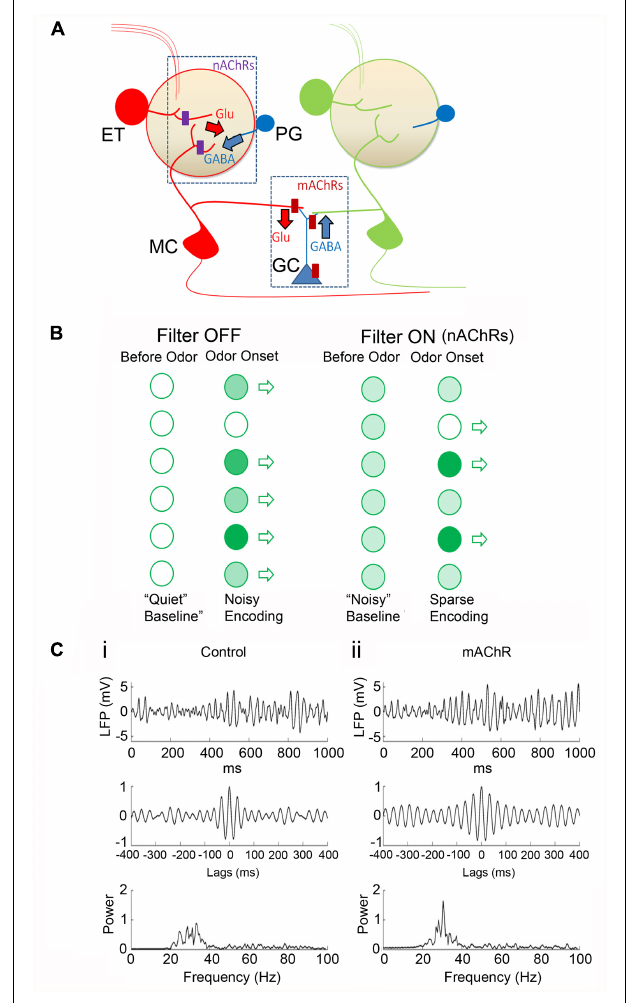
FIGURE 5 |A working model for cholinergic modulation of OB circuitry. (A) Cartoon of the OB circuit showing major sites of cholinergic inhibition. In the glomerular microcircuit, nAChRs (purple rectangles) are expressed in the primary dendritic tufts of MCs and on the ET cell (in red). Activation of these receptors depolarizes the neurons resulting in the release of glutamate (Glu). Released glutamate excites nearby PG cells (blue) eliciting a feedback GABA release on to the excitatory neurons. (A) Similar feedback circuit exists at the dendrodendritic synapses between GCs and secondary dendrites of MCs allowing for lateral inhibition of adjacent MC dendrites. (B) Cartoon showing glomerular output (open arrows). In the absence of receptor activation (Filter OFF) there is less baseline activity (“Quiet baseline.”) Odor stimulations at different strengths (light and dark green circles for weak and strong stimulation, respectively) are transmitted through. Upon nAChR activation, (Filter ON), excitation of ET cells and MCs lead to a noisier baseline (i.e., all light green). However, upon odor input, excitation-driven inhibition results in filtering out of weaker inputs, such that only strong ones pass through. Further, increased basal activity also allows for potential “inhibitory readouts” (open circle) where net MC firing rates can be reduced to levels below that prior to odor onset (see Figure 4C ).The time window of the nAChR-evoked inhibition will determine the efficacy of this filter.Thus determining the temporal patterns of ACh release, in relation to behavioral stages, is necessary in order to predict the direct consequences of this filter mechanism. (C) Modeling the activation of mAChRs in the OB (with permission from Li and Cleland, 2013). In this model, mAChR activation does not alter MC firing rates but the receptor